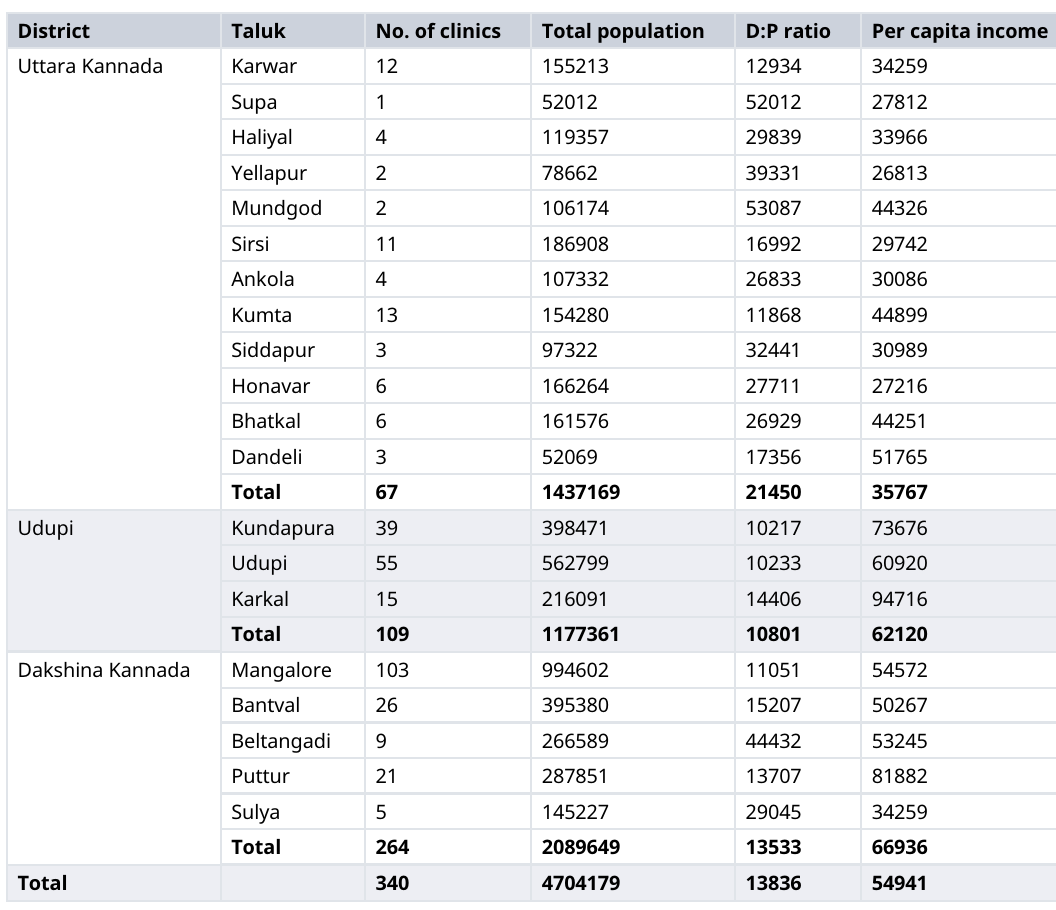
Table 3. Taluk-wise D:P and per-capita income.